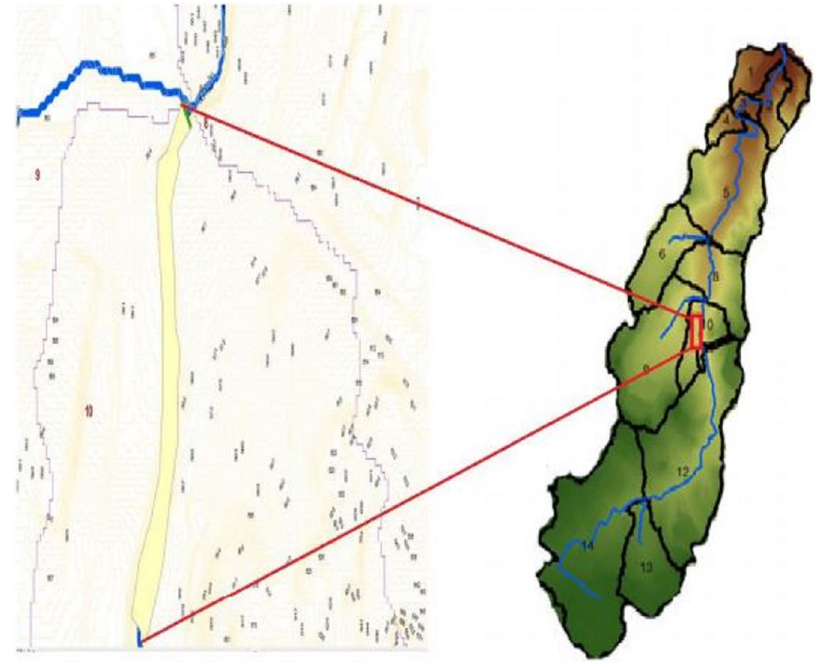
Fig. 3 Location of a detention pond in the